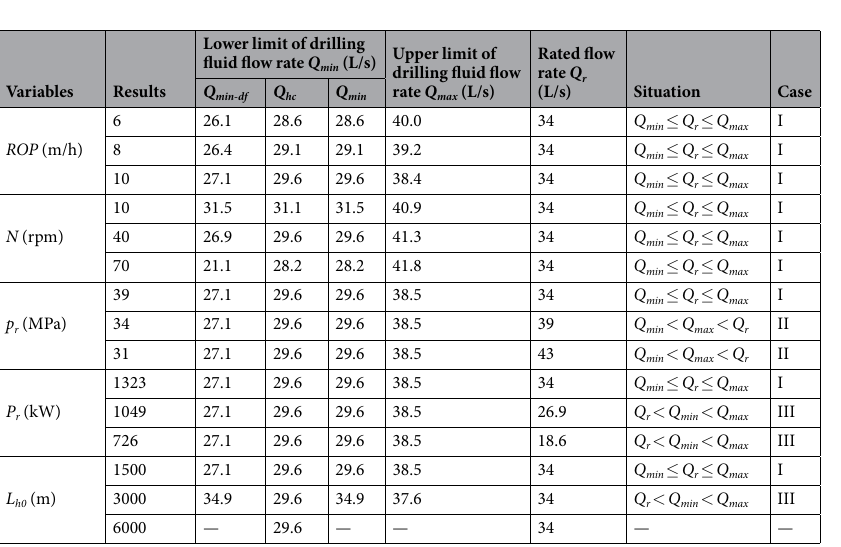
Table 3. Allowable ranges of drilling fluid flow rate under different